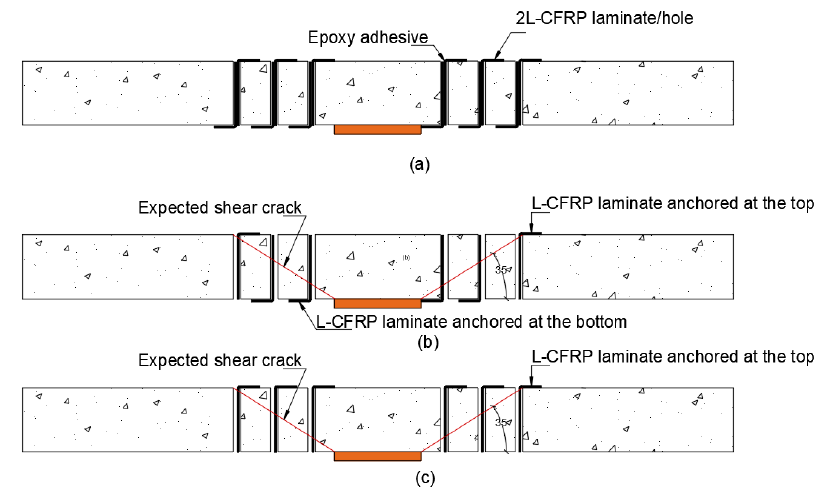
Figure 23. ( a ) Two L-shaped laminates per hole, ( b ) one L-shaped laminate per hole anchored at top or bottom alternately, and ( c ) one L-shaped laminate per hole anchored at the top [48].